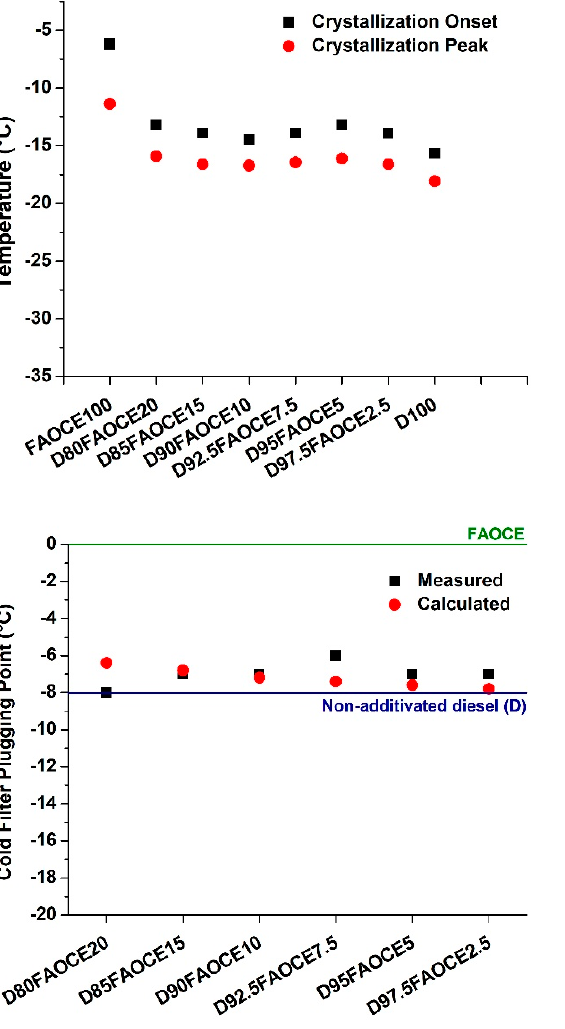
Figure 8. Low-temperature properties (crystallization onset and peak temperatures measured by DSC) and cold filter plugging points of pure components and their binary and ternary blends.